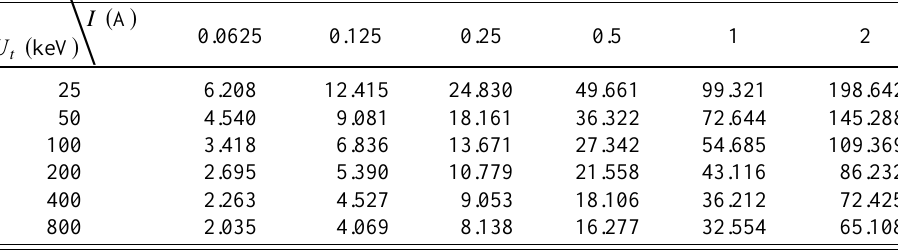
TABLE I. Values of the temperature parameter m e [Eq. (2.6b)] of the electrons in dependence of beam current and energy. At kT e (cid:1) 1 eV these values correspond to the potential depression d U of the uniform beam [Eq.